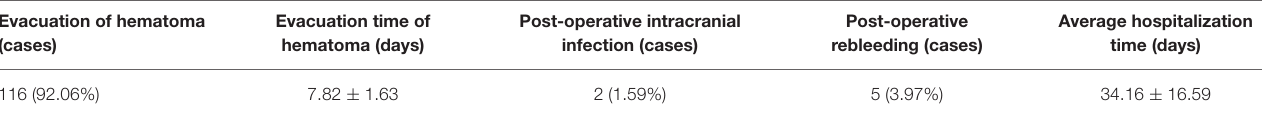
TABLE 2 | Improvement of post-operative clinical symptoms in all patients with hypertensive intracerebral hemorrhage (HICH) (%,_ ¯ x ± s). Evacuation of hematoma